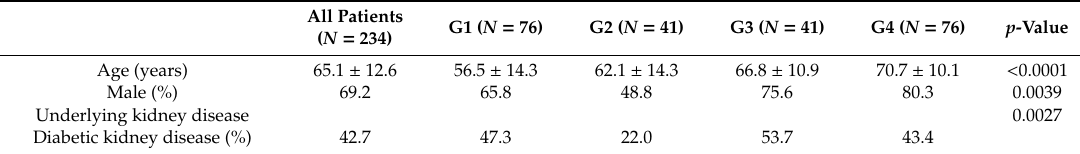
Table 1. Baseline patient